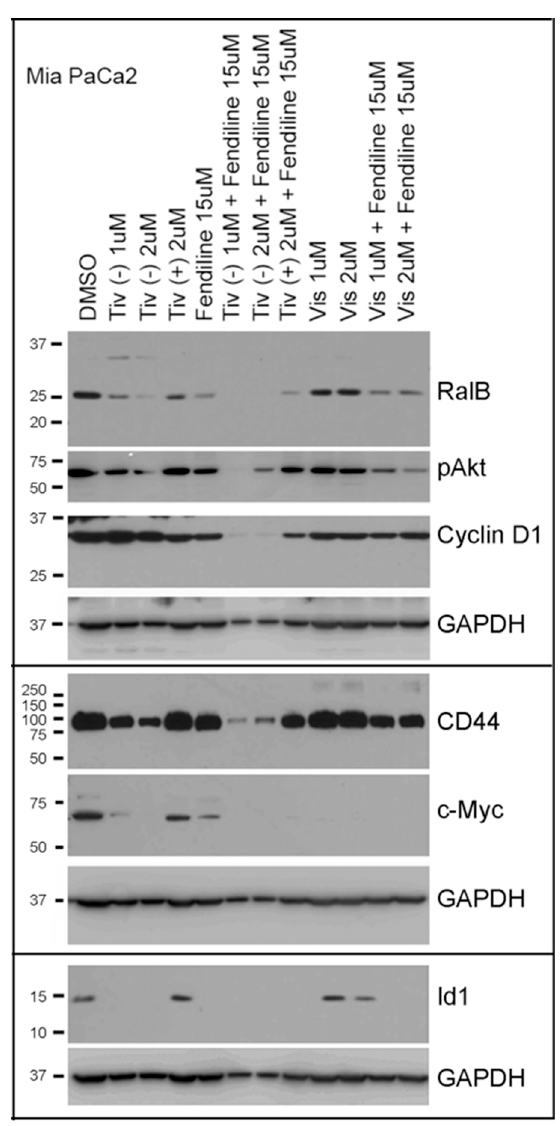
Figure 8. MiaPaCa2 cells treated with a combination of tivantinib or visudyne and fendiline show stronger inhibition of oncgenic signaling: Cells were treated for 24 h with the indicated concentrations of drugs and samples were analyzed by PAGE and western blotting using the antibodies shown. Tivantinib in combination with fendiline showed strong inhibition of CD44, c-Myc, RalB, Cyclin D1, Id1 and P-Akt, implying some of the potential tumor-associated signaling mechanisms targeted by these agents.